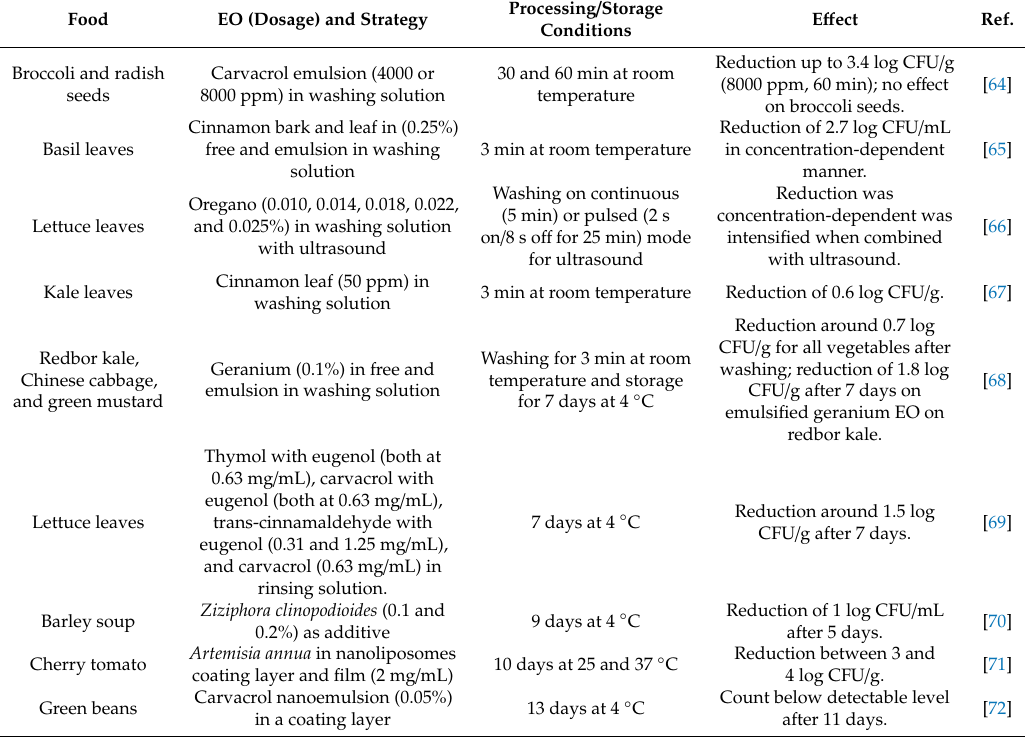
Table 5. Influence of essential oils on pathogenic E. coli in vegetables